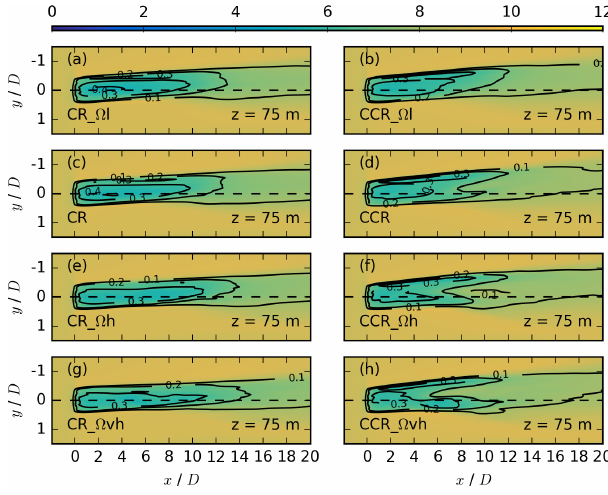
in meters Figure 16. Contours of the streamwise velocity u i,j,k ∗ per second for different rotational frequencies at z = 75m for the same simulations as in Fig. 14. The black contours represent the velocity deficit VD i,j,k at the same vertical location. ∗ Figure 17. Vertical profile (first column) and horizontal profiles at z = 75m (second column), z = 100m (third column), and z = 125m (fourth column) of the 30min averaged streamwise velocity at x = 7D downwind of the actuator for a rotational frequency of (cid:127) = 0.058 ◦ s − 1 in (a–d) , (cid:127) = 0.12 ◦ s − 1 in (e–g) , (cid:127) = 0.175 ◦ s − 1 in (i–l) , and (cid:127) = 0.23 ◦ s − 1 in (m–o)